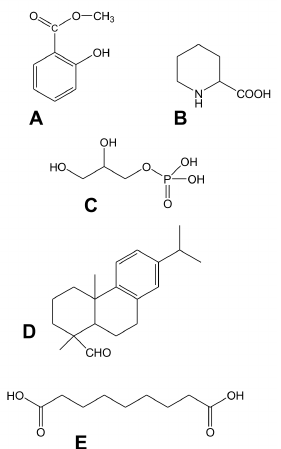
Figure 2. Chemical structures of signal compounds participating in SAR induction. ( A ) Phenolic compound, methyl-salicylate; ( B ) Non-protein amino acid, pipecolic acid; ( C ) Glycerol-3-phosphate; ( D ) Geranylgeranyl diphosphate derived dehydroabietinal; ( E ) Dicarboxylic acid, azelaic